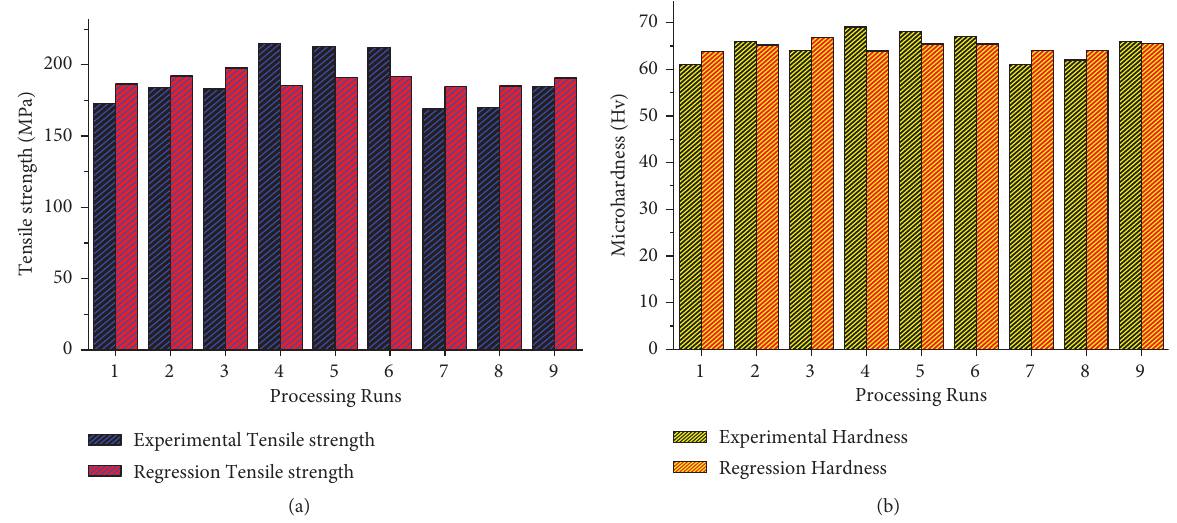
Figure 9: Experimental and regression values of (a) tensile strength and (b)